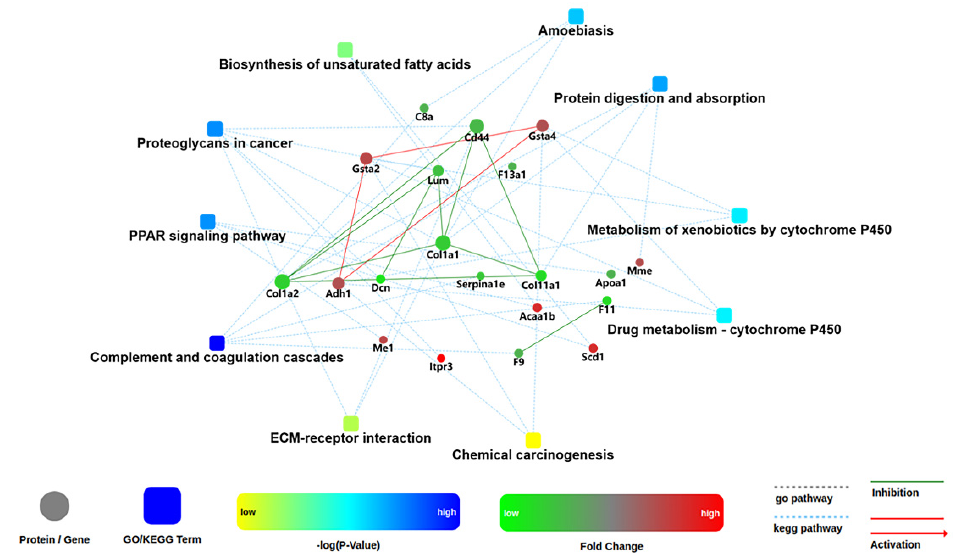
Figure 11. Network analysis of enriched pathways and interactions. Pathways were colored with a gradient color from yellow to blue; yellow for a smaller p -value, blue for bigger p -value. In case of fold change analysis, genes/proteins were colored in red (up-regulation) and green (down-regulation). The default confidence cutoff of 400 was used: interactions with bigger confident score were shown as solid lines between genes/proteins, otherwise in dashed lines.